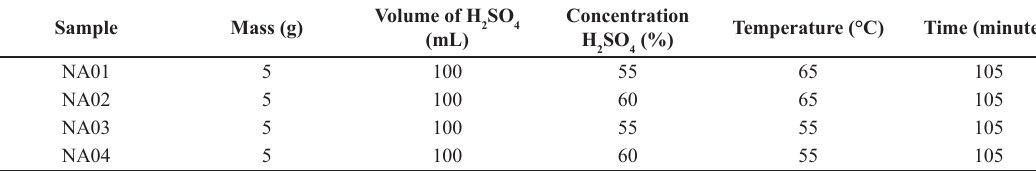
Table 1. Acid hydrolysis conditions for nanowhiskers obtaining.